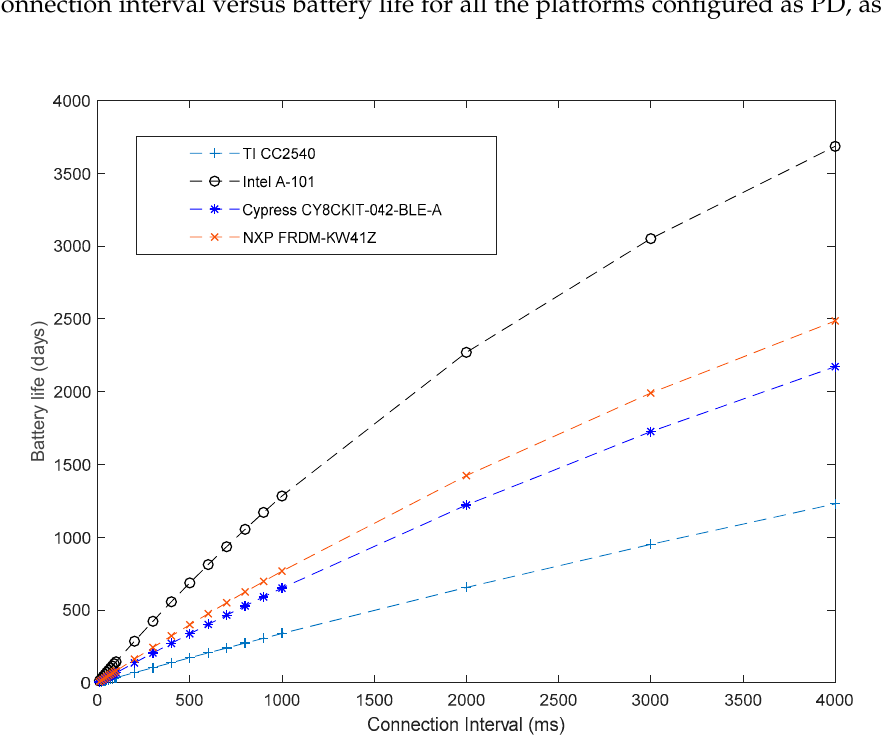
Figure 6. Connection interval vs. battery life in CD mode.